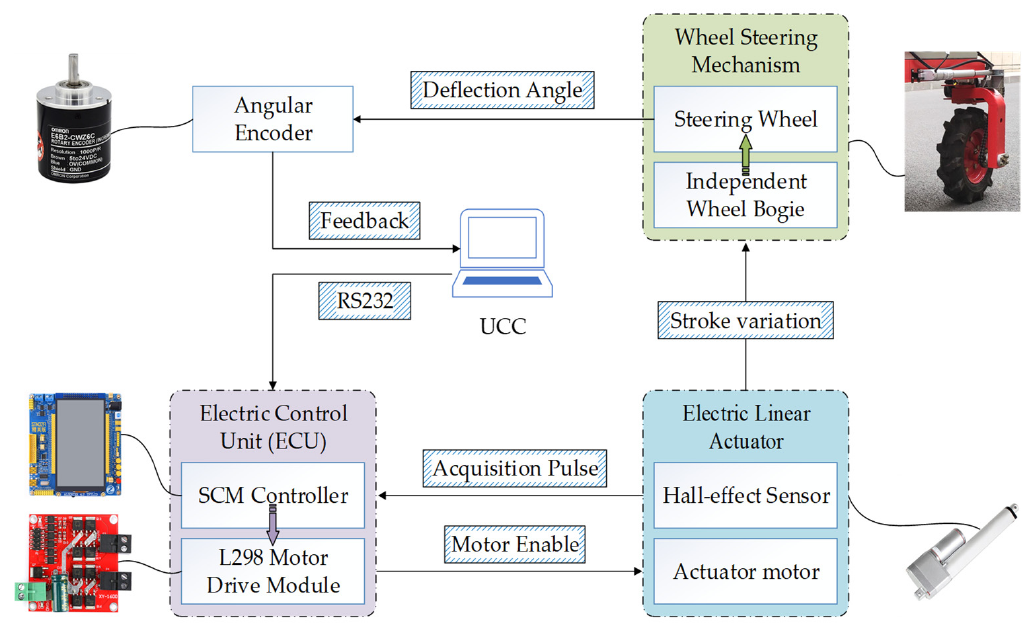
Actuators 2021 , 10 , x FOR PEER REVIEW Figure 4. Hardware architecture of deflection control system. Figure 4. Hardware architecture of deflection control system.